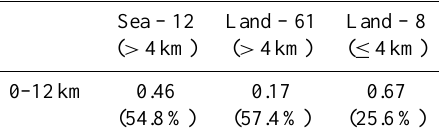
Table 3. Summary of correlations between retrieved IASI O 3 and smoothed lidar O 3 [0–12km] columns for the summer campaign according to surface type. The profiles are separated according to the flight altitude of the ATR-42 (threshold at 4km). The number of observations is provided next to the surface type. The relative difference is given in